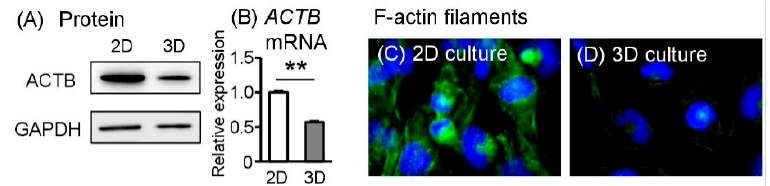
Figure 4. Effects of 3D culture conditions on the actin cytoskeleton in Sw.71 cells. Sw.71 trophoblast cells were incubated for 24 h under 2D or 3D culture plates. ( A ) After 24 h incubation, β -actin (ACTB) and GAPDH protein levels in the cell lysates were detected using Western blot. Representative data are shown. ( B ) ACTB mRNA levels were measured using RT-qPCR ( n = 4). ( C , D ) Representative images of F-actin filaments staining after 2D, 3D culture (×400 magnification). Data are expressed as mean ± SEM ( n = 4 in each experiment). Significant differences were detected using t -test; p < 0.05 (*) p < 0.01 (**)